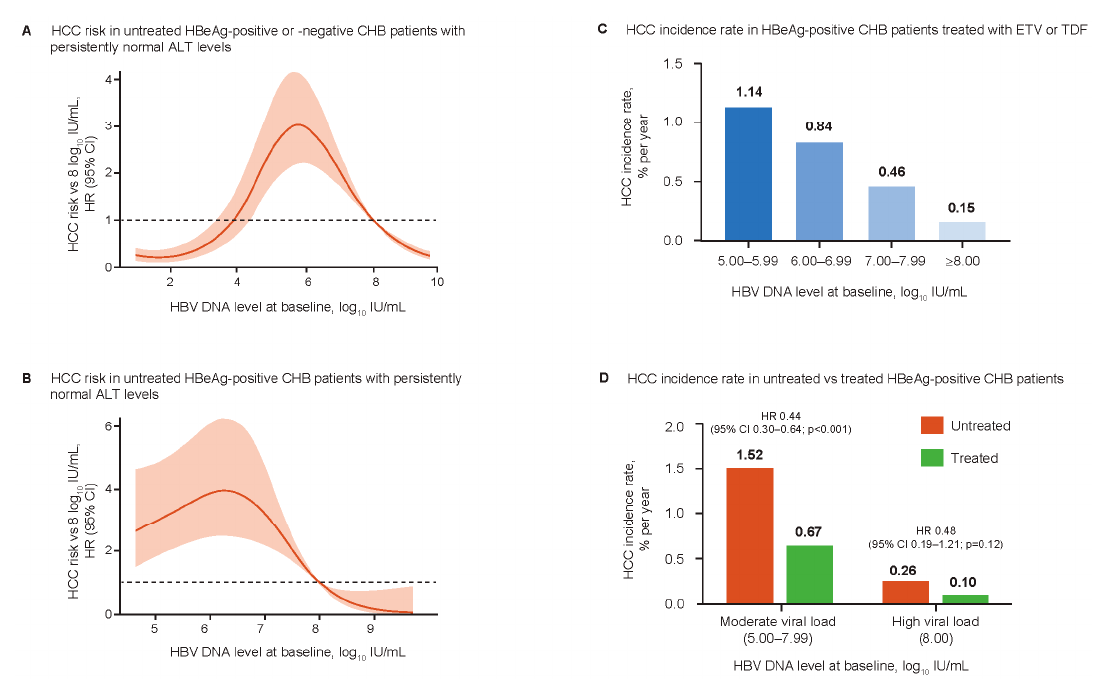
Figure 2. Association between the baseline HBV DNA levels and HCC risk in untreated and NA- treated non-cirrhotic adult patients with CHB. ( A ). In untreated HBeAg-positive and -negative, non-cirrhotic, adult CHB patients with persistently normal ALT levels ( n = 6949), HCC risk was the highest with baseline levels of approximately 6 log 10 IU/mL. ( B ). In untreated HBeAg-positive, non-cirrhotic, adult CHB patients with persistently normal ALT levels ( n = 2081), HCC risk was the highest with baseline HBV DNA levels of approximately 6 log 10 IU/mL. ( C ). In HBeAg-positive, non-cirrhotic, adult CHB patients treated with ETV or TDF ( n = 2073), the on-treatment HCC incidence rate increased incrementally with decreasing baseline HBV DNA levels ≥ 5 log 10 IU/mL. ( D ). Compared with untreated HBeAg-positive, non-cirrhotic adult CHB patients with normal ALT levels ( n = 2643), NA treatment in HBeAg-positive, non-cirrhotic, adult CHB patients ( n = 2073) reduced the HCC incidence in patients with moderate baseline viral load (5.00–7.99 log 10 IU/mL), but the HCC risk did not decrease to the same extent in patients with a high baseline viral load ( ≥ 8.0 log 10 IU/mL). ALT, alanine aminotransferase; CHB, chronic hepatitis B; CI, confidence interval; ETV, entecavir; HBeAg, hepatitis B envelope antigen; HBV, hepatitis B virus; HCC, hepatocellular carcinoma; HR, hazard ratio; NA, nucleos(t)ide analog; TDF, tenofovir disoproxil fumarate. All panels in this figure were made by Y-S Lim based on data in Kim G-A et al. Aliment Pharmacol Ther. 2020;51:1169–1179 (panels A and B ) and Choi W-M et al. J Clin Invest. 2022;132:e154833 (panels C and D